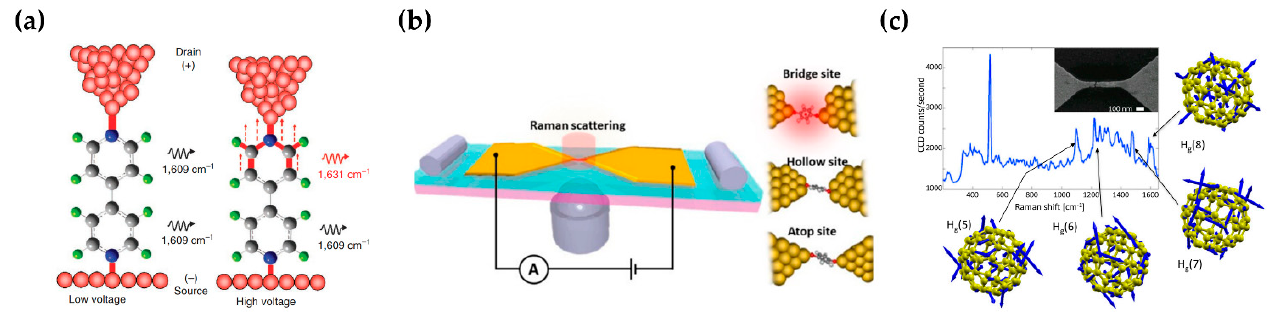
Figure 5. Characterization of molecular nanoelectronics by SM-SERS. ( a ) The schematic of the Au– 4bipy–Au junction with low/high bias voltage. Figure reproduced from [64]. ( b ) Simultaneous SERS and conductance measurements for single-molecule junction. Figure reproduced from [100]. Right: three metastable states in BDT junctions. ( c ) SERS of C 60 in an electromigrated junction. Figure reproduced from [102]. Inset: an SEM image of an electromigrated